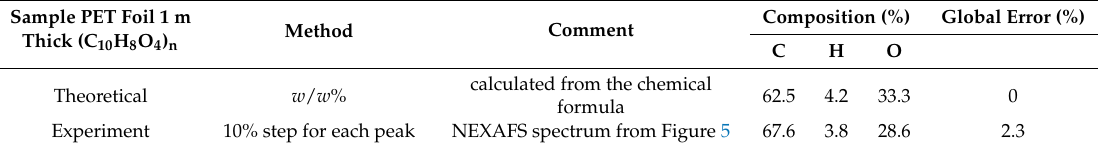
Table 2. The experimental elemental composition of the analyzed PET sample compared to the theoretical composition values. A 10% step function for each Gaussian type peak fitting curve was used as a fitting method.